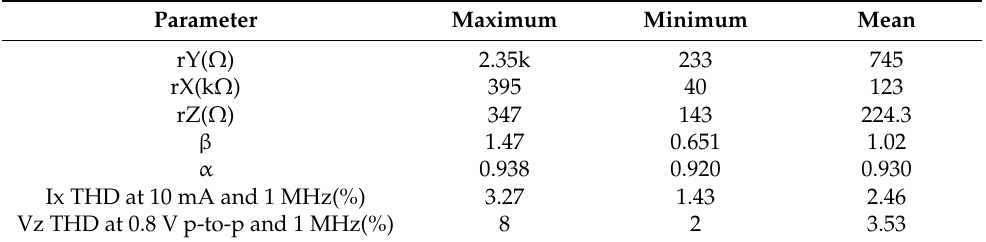
Table 4. Monte-Carlo Simulation Results.